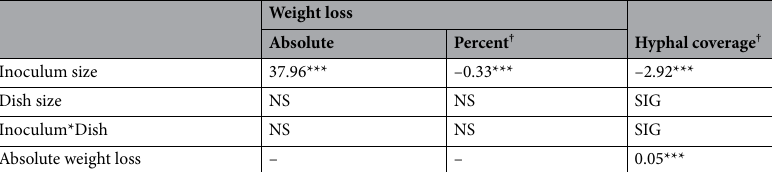
Table 2. Results of linear regression showing the estimated coefficients for the weight loss of wood blocks and hyphal coverage growing on the soil. NS, not significant; SIG, significant. *** P <